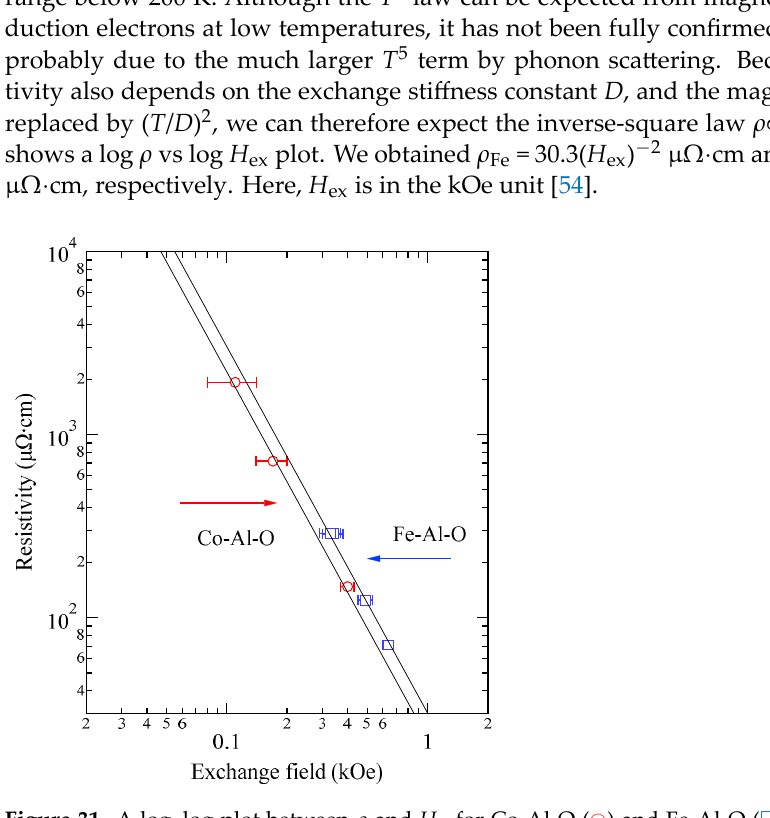
5 Figure 32. BLS spectrum from the SPM and FM Co-Al-O films at room temperature under an ex- ternal magnetic field of 2.0 kOe. Here, ( a ) x (Co) = 72.4, ( b ) x (Co) = 67.5, ( c ) x (Co) = 63.1, ( d ) x (Co) = 50.3, and ( e ) x (Co) = 49.9, respectively. The baseline for each spectrum was properly shifted for clarity’s sake. The solid lines give the numerical fits by the CM theory. The vertical broken lines indicate the frequency area in which the AOMs were activated to protect the PMT. An intensi- ty-attenuated elastic Rayleigh peak around zero frequency is also displayed. This peak gives the instrumental function [101].